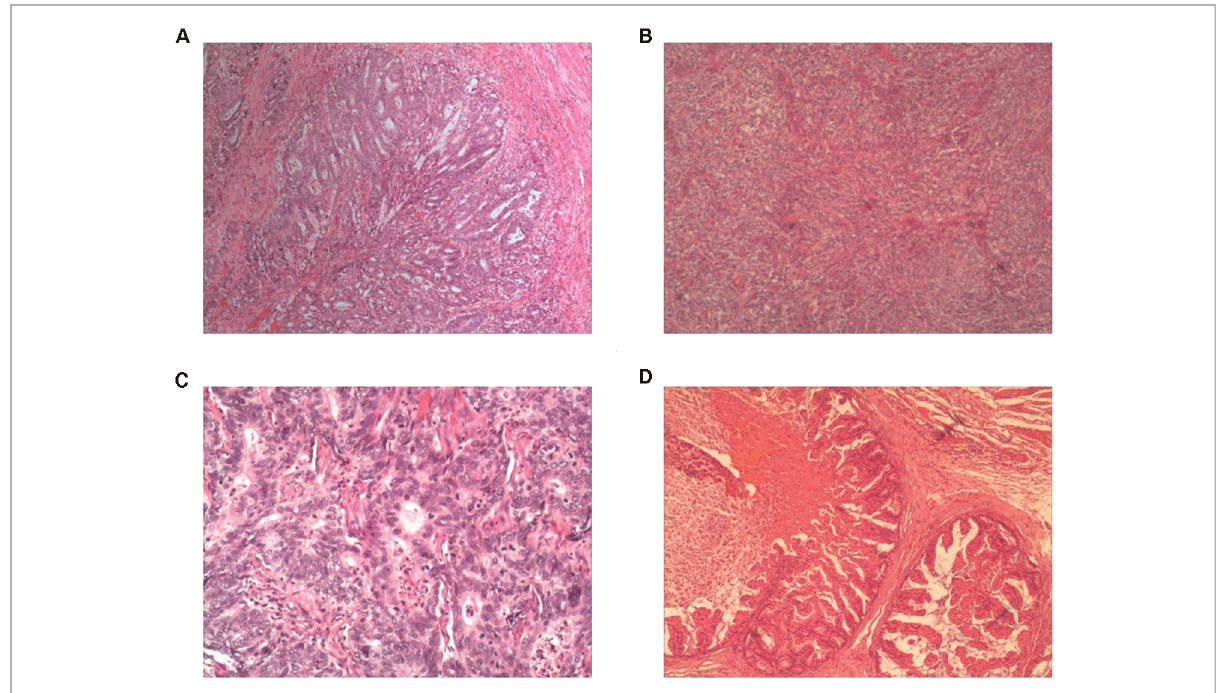
FIGURE 4 ( A ) Pathology results from the totally endoscopic group by total gastrectomy; ( B ) pathology results from the laparoscopy-assisted group by total gastrectomy; ( C ) pathology results from the totally endoscopic group by proximal gastrectomy; ( D ) pathology results from the laparoscopy- assisted group by proximal